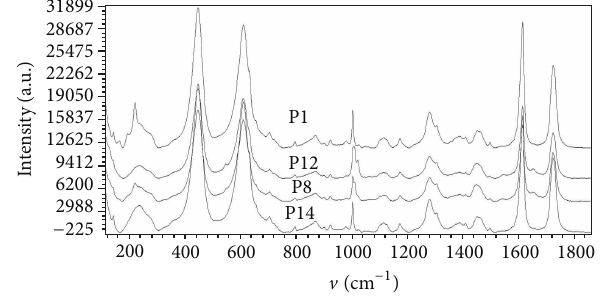
Figure 10: Micro-Raman spectra at grey areas of sample M2 where salmon adhesion was observed. Spectral plots P1, P8, P12, and P14 correspond to points 01, 08, 12, and 14 in Figure